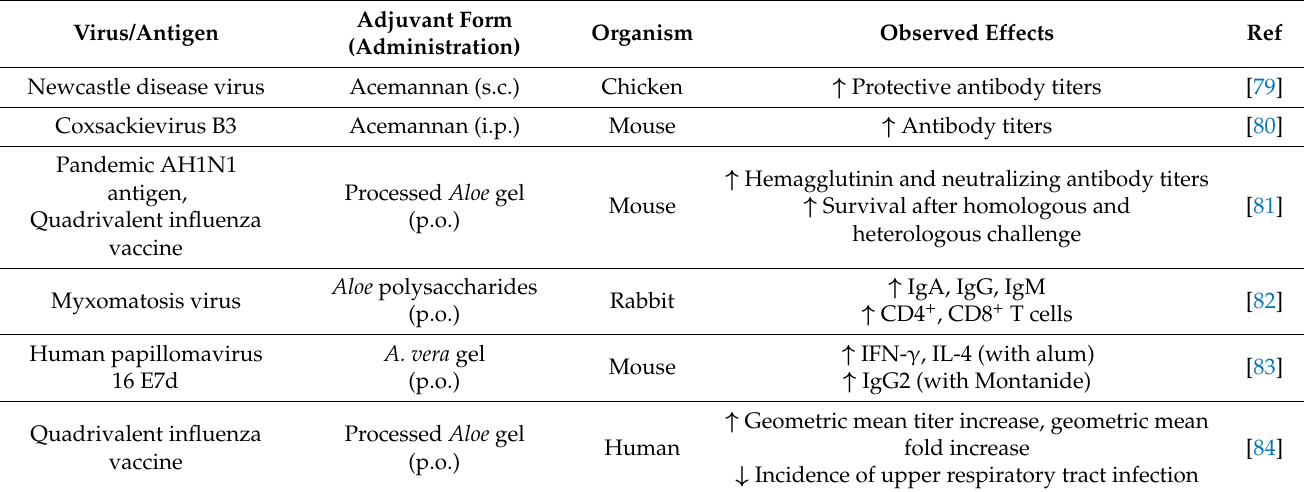
Table 4. Adjuvanticity of A. vera components in viral